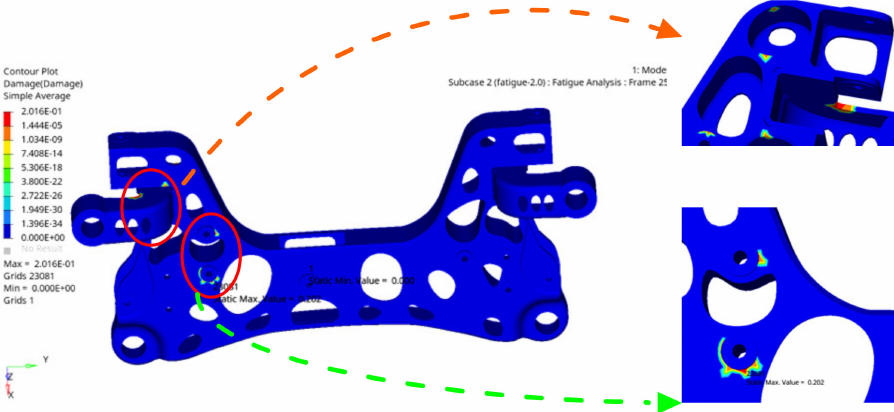
Figure 19. Fatigue damage cloud image of aluminium alloy front subframe over one side deep pit condition.